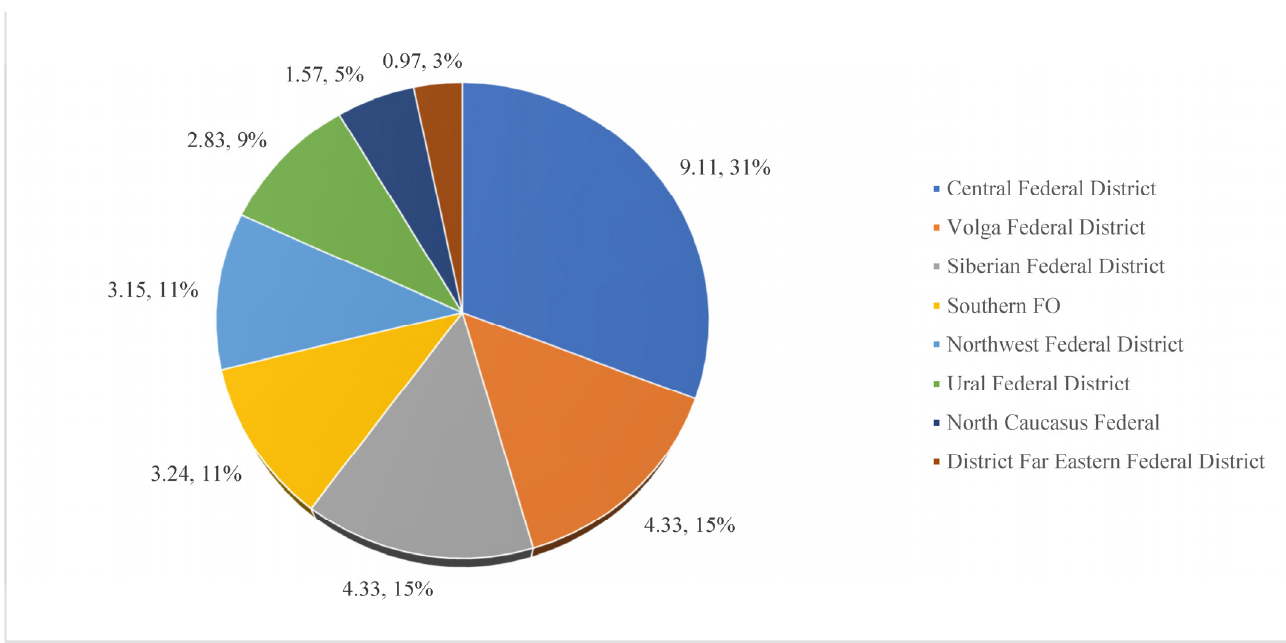
Figure 8. Grouping of federal districts of the Russian Federation by volume of gasoline consumption, 2020.